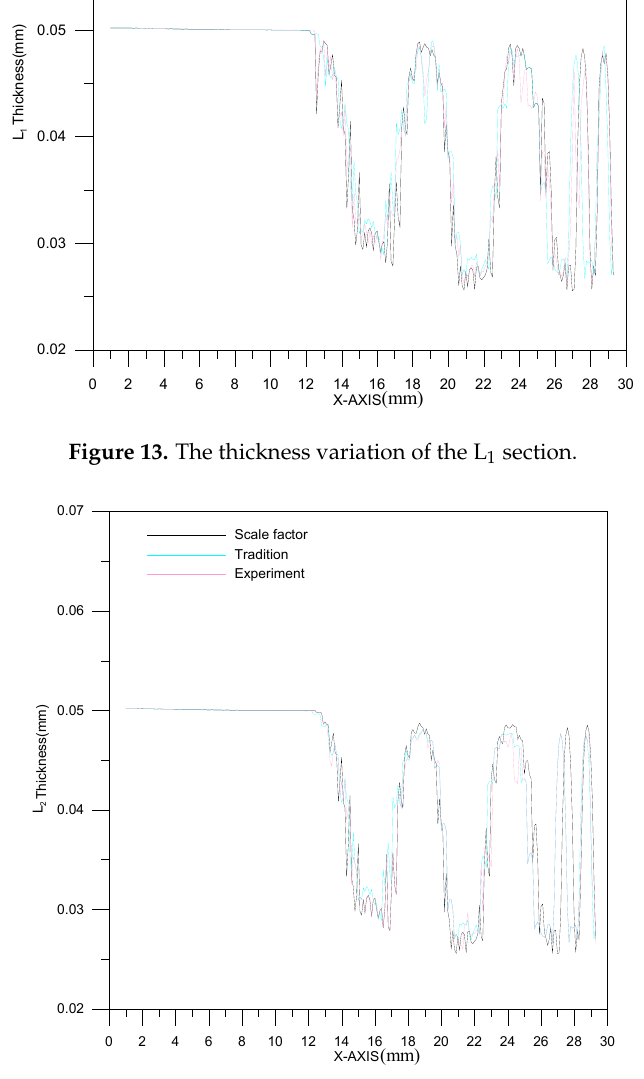
Figure 14. The thickness variation of the L 2 section.